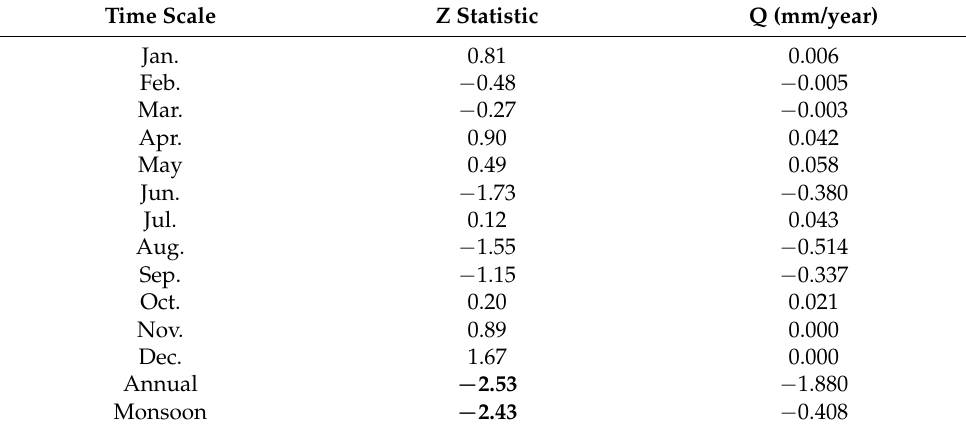
Table 3. MK-test statistic and Sen’s slope values for 116 years monthly